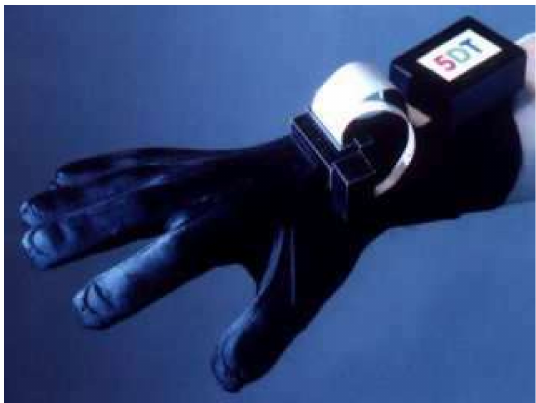
Figure 20. The 5DT Data GloveTM developed by Fifth Dimension Technologies; the glove measures seven DOF [74].